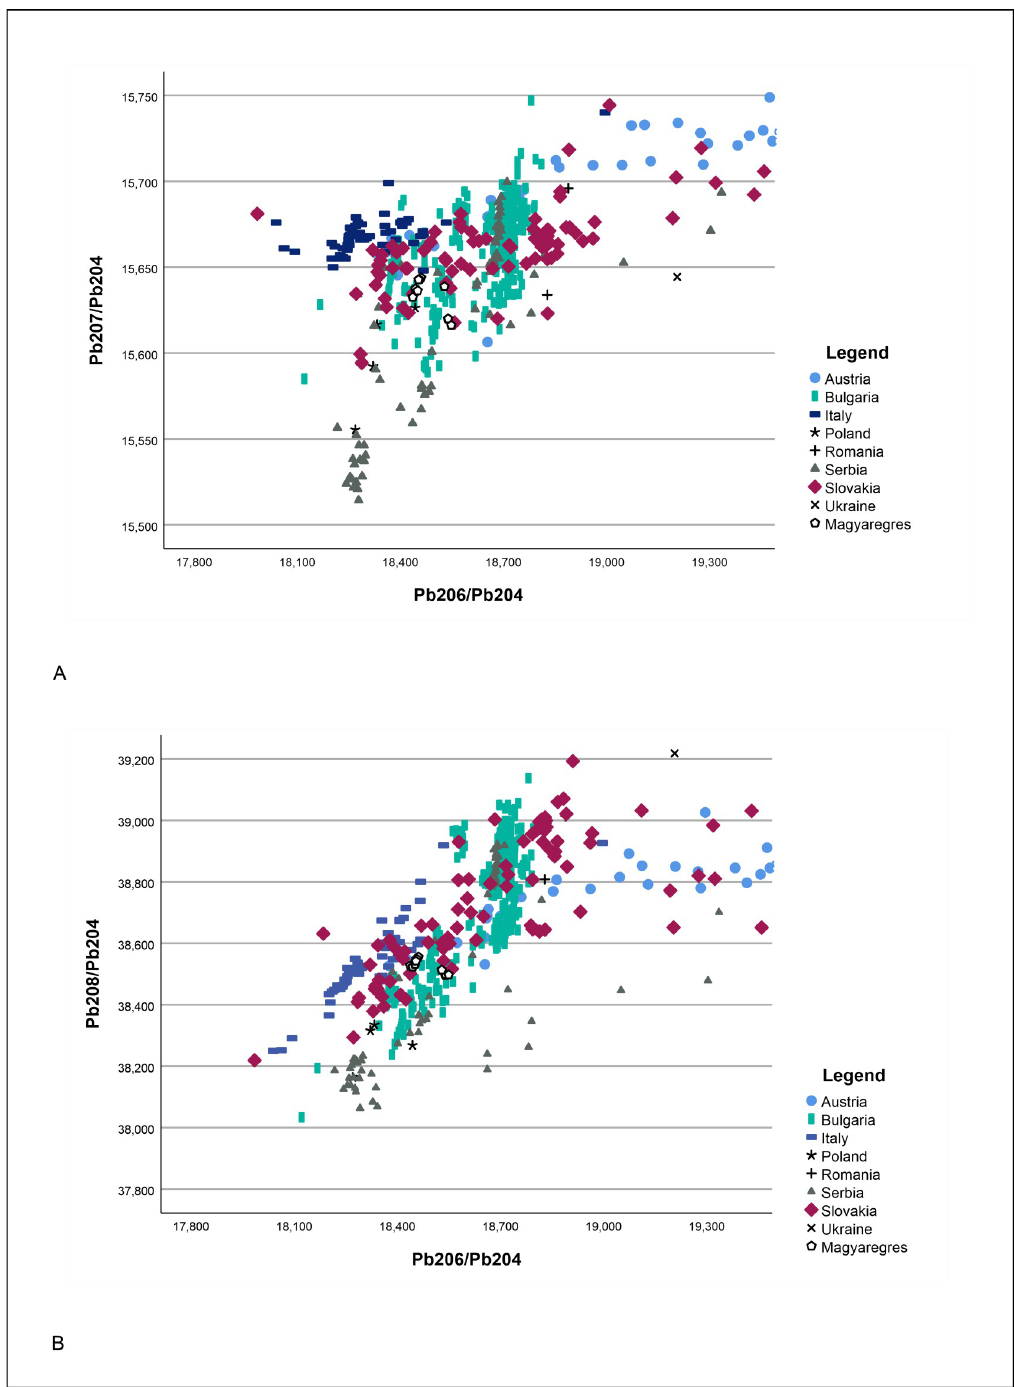
Fig 21. Potential raw material sources of the Magyaregres hoard copper ornaments based on lead isotope analysis. Bivariate plots show the measured lead isotope ratios, compared with the potential ore sources [17–19,32,34,81–84]according to (A) 206 Pb/ 204 Pb vs 207 Pb/ 204 Pb and (B) 206 Pb/ 204 Pb vs 208 Pb/ 204 Pb.